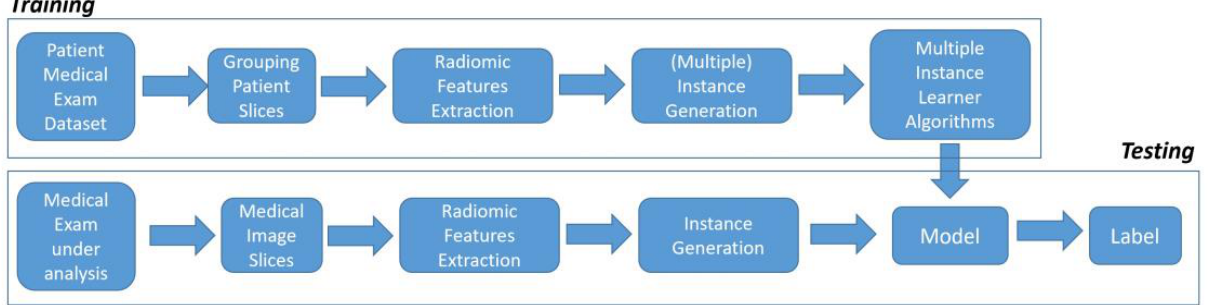
Figure 1. The proposed method for pulmonary nodule detection.